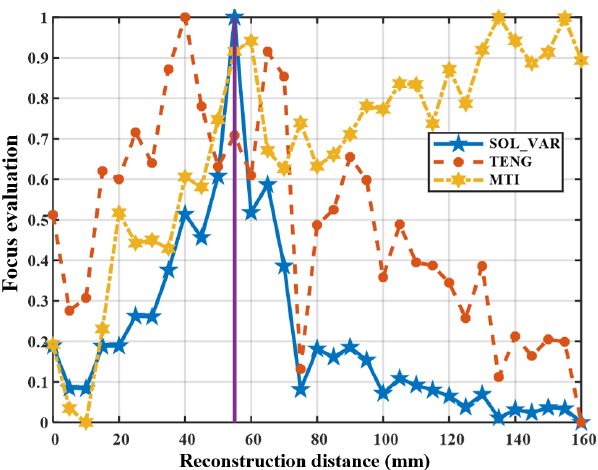
Figure 8. The assessment of each plane in Figure 6 using the SOL_VAR, TENG, and MTI functions (the results were normalized). The purple vertical line represents the position of the actual focus plane.